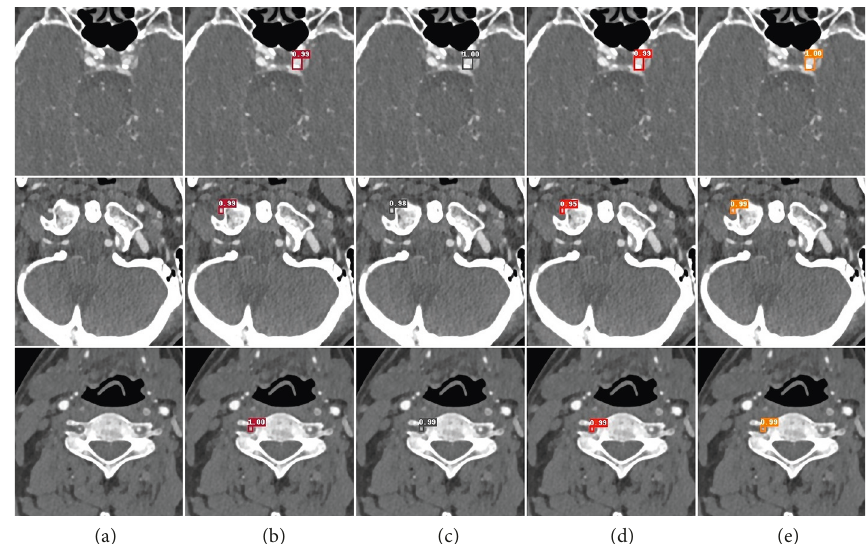
Figure 11: Prediction of retrained Libra R-CNN. (a) Raw image, (b) Libra R-CNN, (c) Libra R-CNN+dcn, (d) Libra R-CNN+dcn+non- local, and (e) Libra R–CNN+dcn+nonlocal+cascade detector.